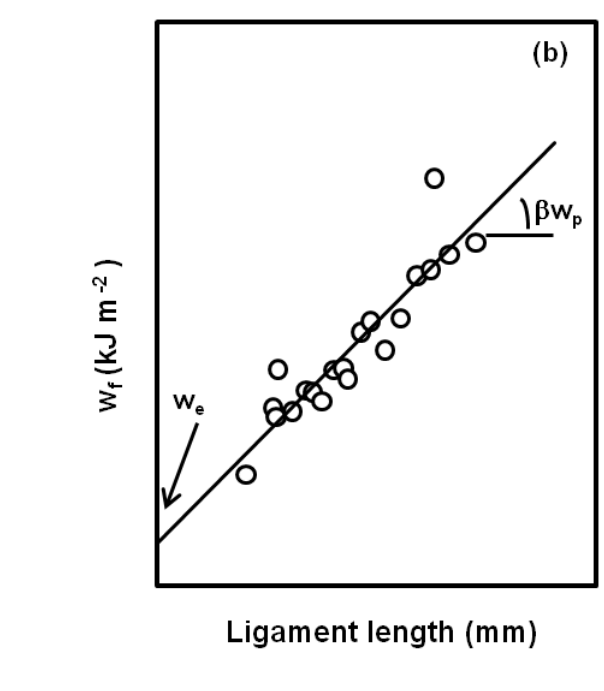
and w ) from load-displacement curves e p